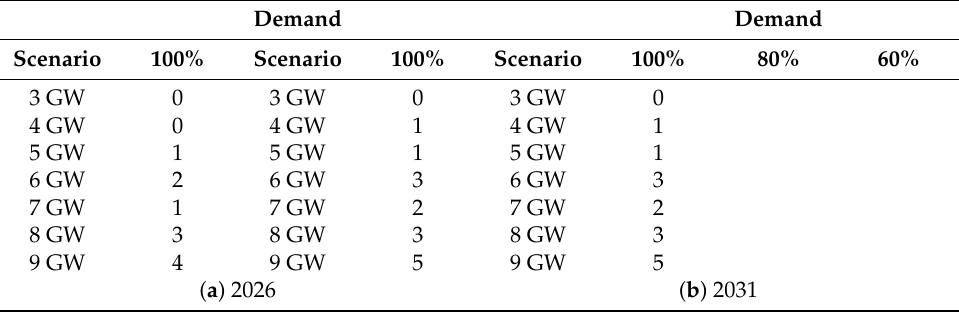
Table 6. The frequency of non-convergence found via the contingency